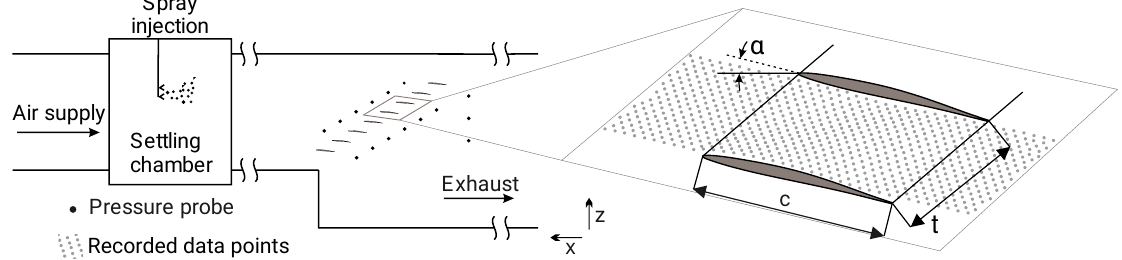
Figure 1. Illustration of the measurement section at the LSM. Detail: Depiction of the cascade nomenclature with the measurement grid positions underneath.